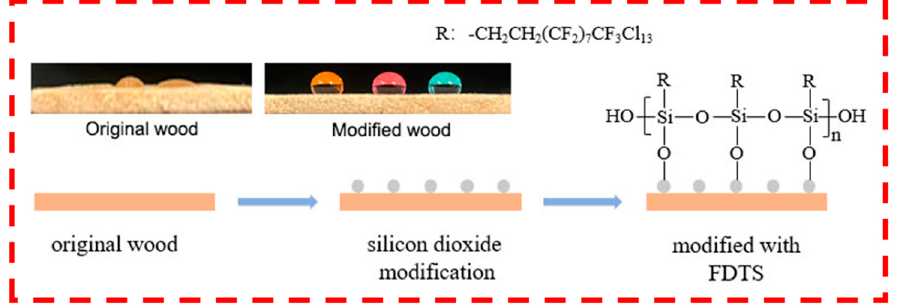
Figure 6. The forming processes of superhydrophobic wood surface. R represents the hydrophobic group.